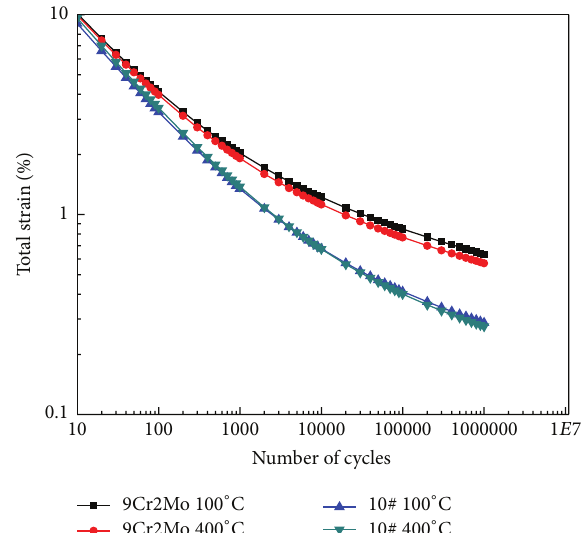
Figure7: Δ𝜀 - 𝑁 curvesofalloy9Cr2Moandtheoptimumalloy(10#) at different temperature in 100Hz load